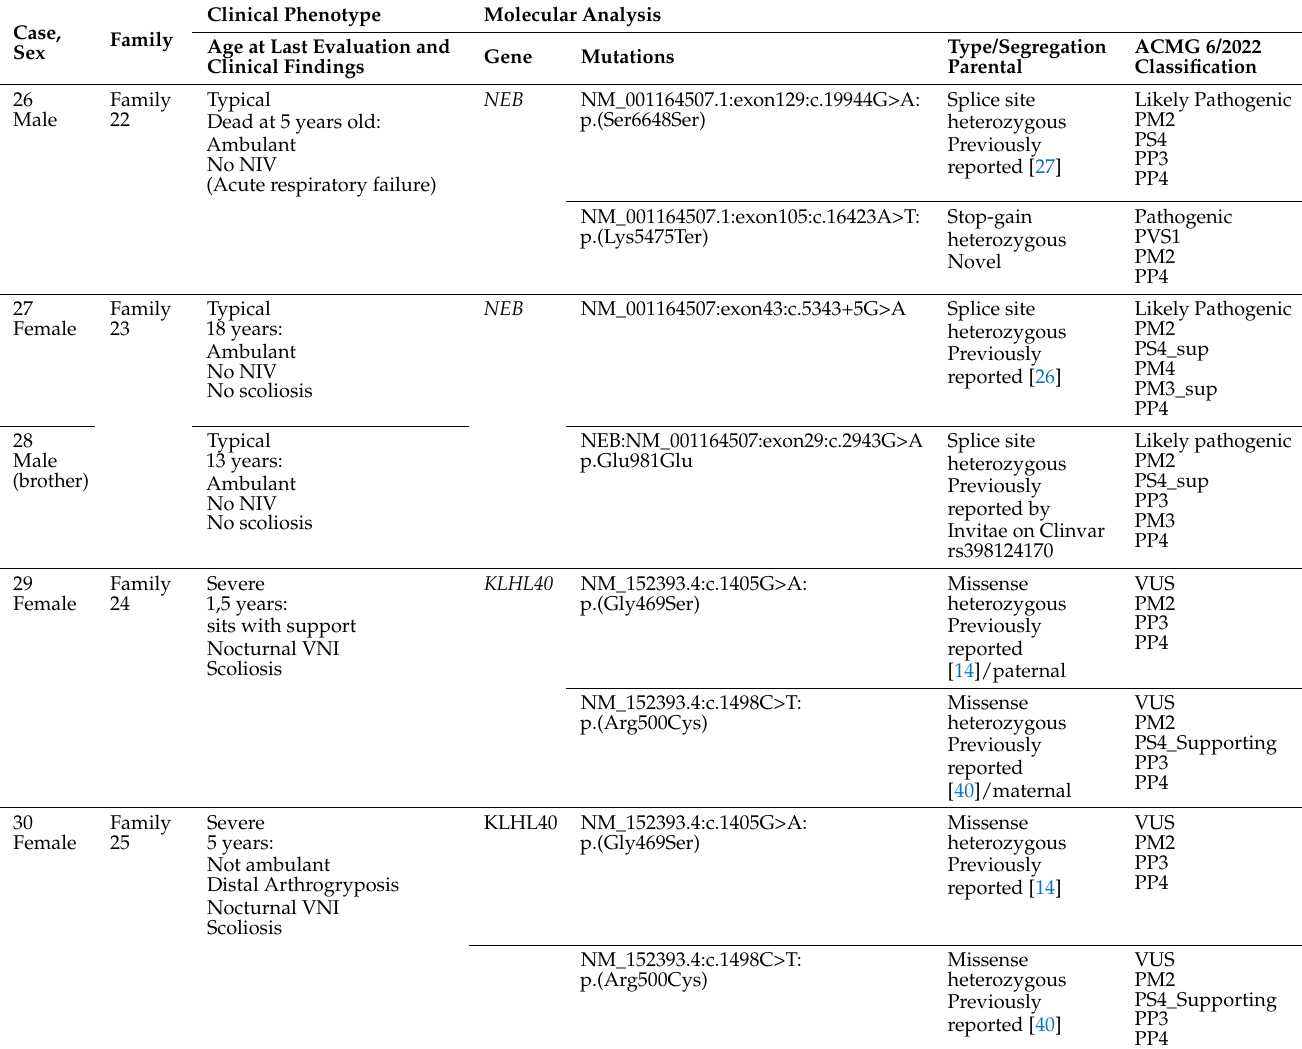
All patients who underwent muscle biopsy presented rods in muscle fibers. The distribution of rods inside muscle fibers was predominantly a mixed pattern of large subsarcolemmal rods associated with small intermyofibrillar rods (Figure 1).